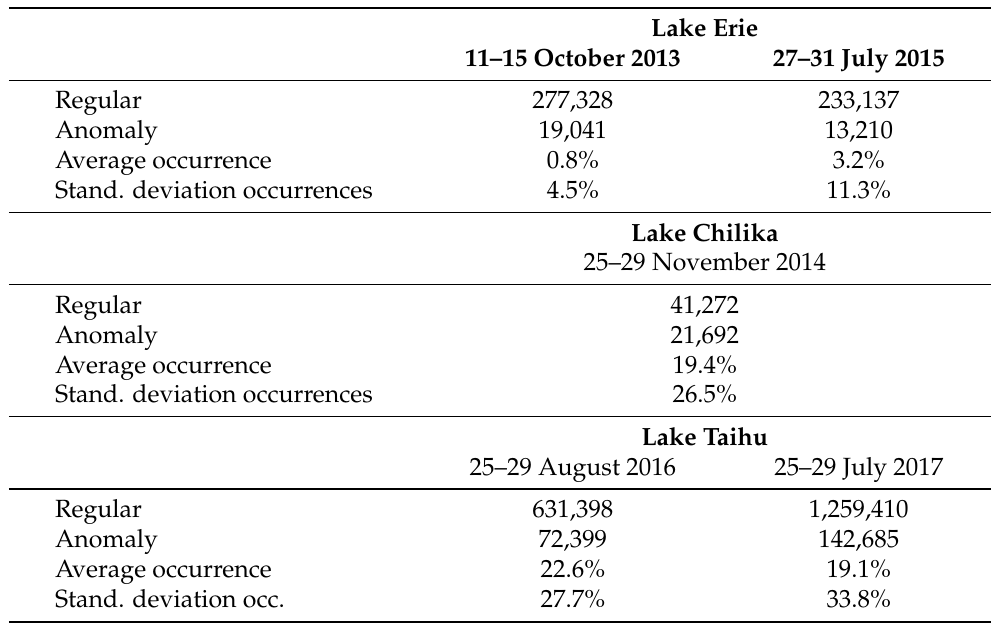
Figure 10. Images ( a – e ) in false-color composition (NIR, red and green bands) for the Lake Taihu study area from 25–29 July 2017. Regular, anomaly, land/cloud/shadow and undetermined samples ( f – j ) are identified by cyan, magenta, gray and black polygons, respectively; ( l – p ) show the local anomaly concentration at each instant; ( k , q ) represent the discrete and local anomaly concentration references for the whole forecasting period. Table 2. Summary of regular and anomaly pixels regarding each study area and early